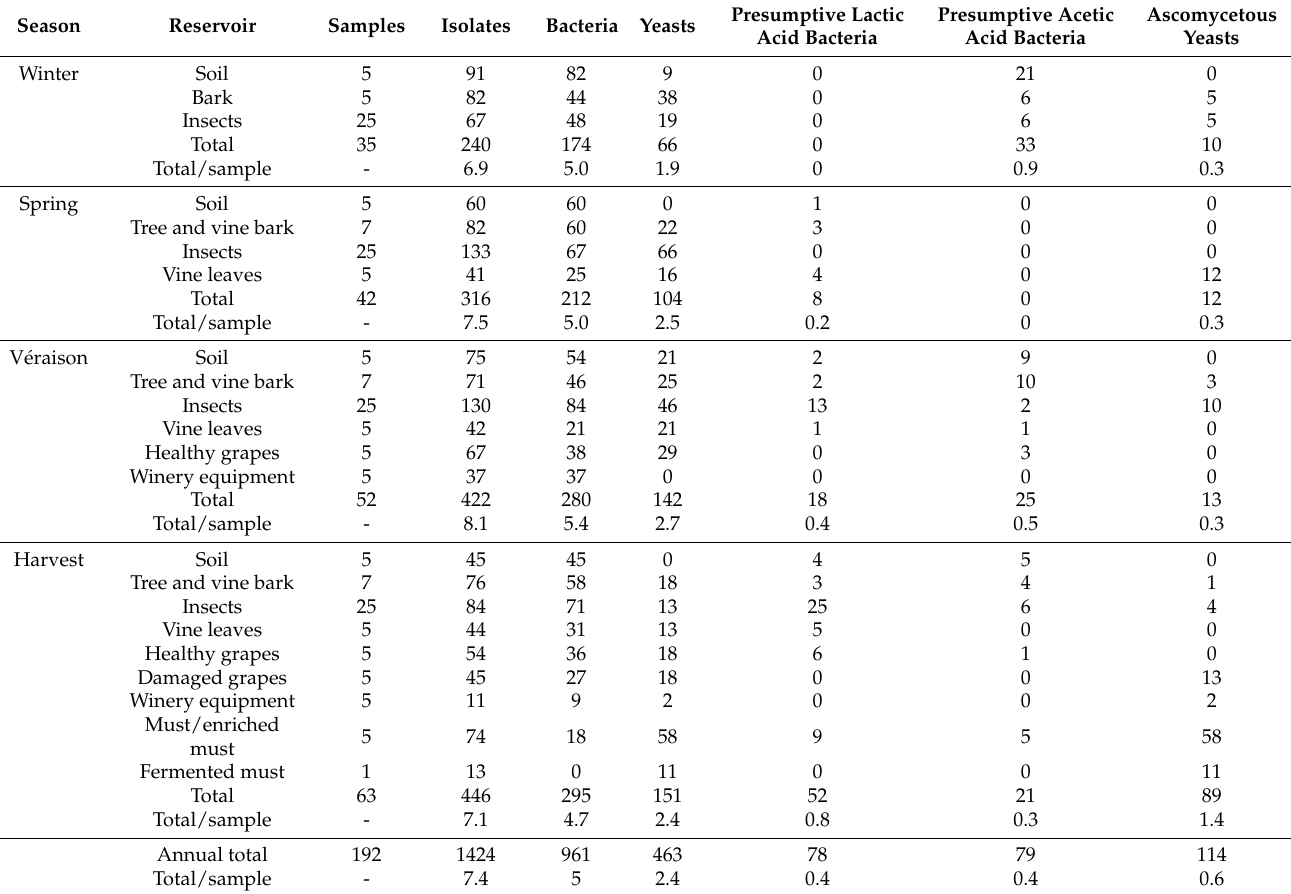
Table 1. Number of samples and microbial isolates during all